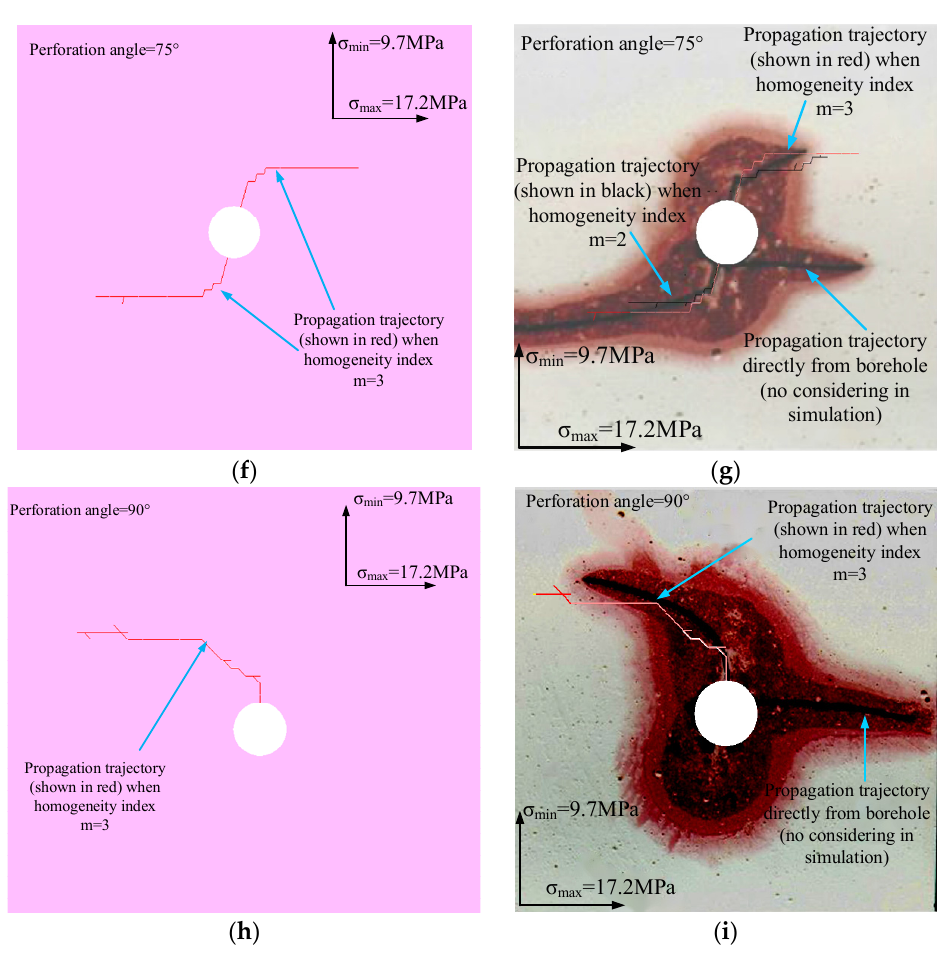
Figure 4. Validation results and comparison: ( a ) schematic of HF re-orientation; ( b ) the simulation result at a perforation angle of 45° when the homogeneity index is 3; ( c ) the simulation result (red line) when the homogeneity index is 3 is compared with the simulation result (black line) of He et al. [5] and the experimental result of Abass et al. [20,23] (perforation angle = 45°); ( d ) the simulation result at a perforation angle of 60° when the homogeneity index is 3; ( e ) the simulation result (red line) when the homogeneity index is 3 is compared with the simulation result (black line) of He et al. [5] and the experimental result of Abass et al. [20,23] (perforation angle = 60°); ( f ) the simulation result at a perforation angle of 75° when the homogeneity index is 3; ( g ) the simulation result (red line) when the homogeneity index is 3 is compared with the simulation result (black line) of He et al. [5] and the experimental result of Abass et al. [20,23] (perforation angle = 75°); ( h ) the simulation result at a perforation angle of 90° when the homogeneity index is 3; ( i ) the simulation result (red line) when the homogeneity index is 3 is compared with the experimental result of Abass et al. [20,23] (perforation angle = 90°).